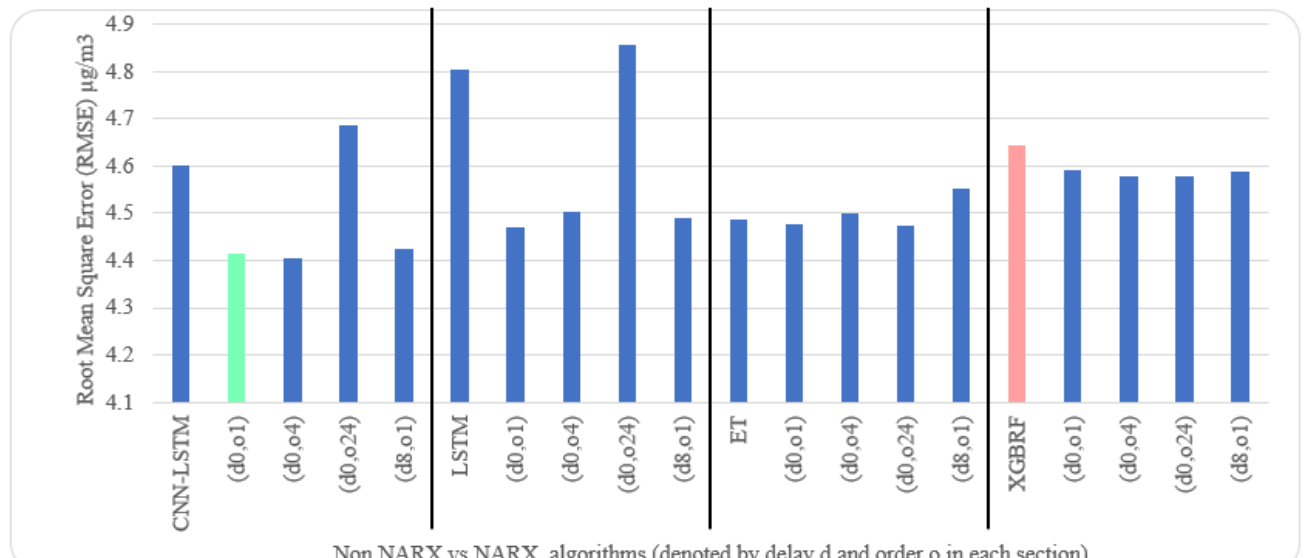
Figure 30. Evaluation results of non-NARX and NARX in terms of normalised root mean square error for the Manchester dataset.